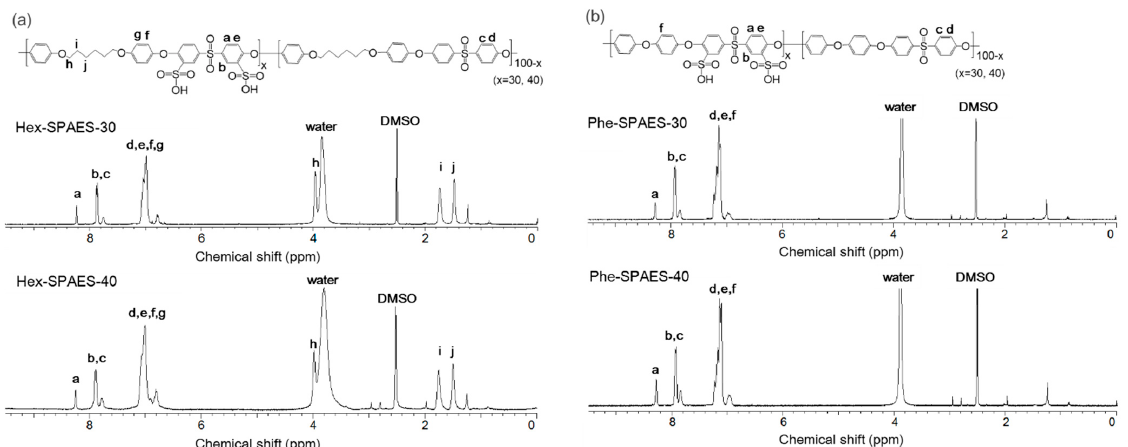
Figure 1. The 1 H NMR (400 MHz; DMSO- d 6 ;Me 4 Si) spectra of the synthetic polymer membranes: ( a ) Hex-SPAES-x bearing hexyl aliphatic chains; ( b ) Phe-SPAES-x containing no aliphatic chains (“Hex” and “Phe” refer to the “hexyl” and “phenyl”, respectively; “x” represents the percentage of repeating units containing sulfonic acid).